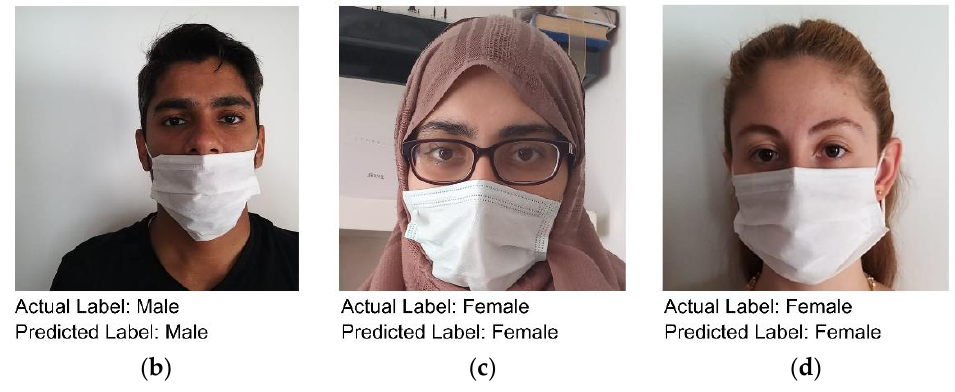
Figure 6. Results obtained when different input images were tested on our gender detection system. ( a ) image of a male, predicted as male; ( b ) image of a male, predicted as male; ( c ) image of a female, predicted as female; ( d ) image of a female, predicted as female.